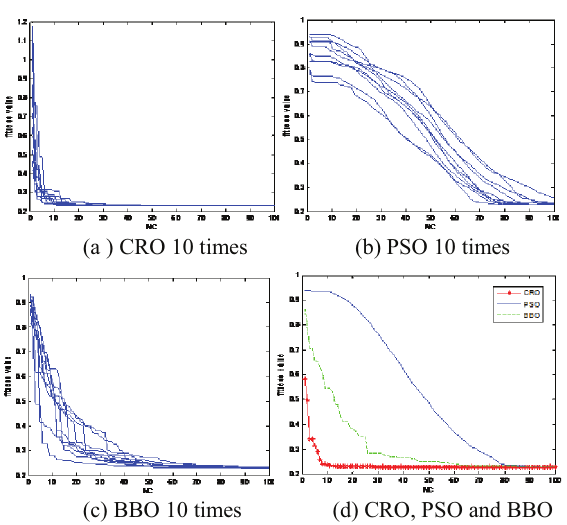
Fig. 7. Evolution curves of CRO, PSO and BBO in our